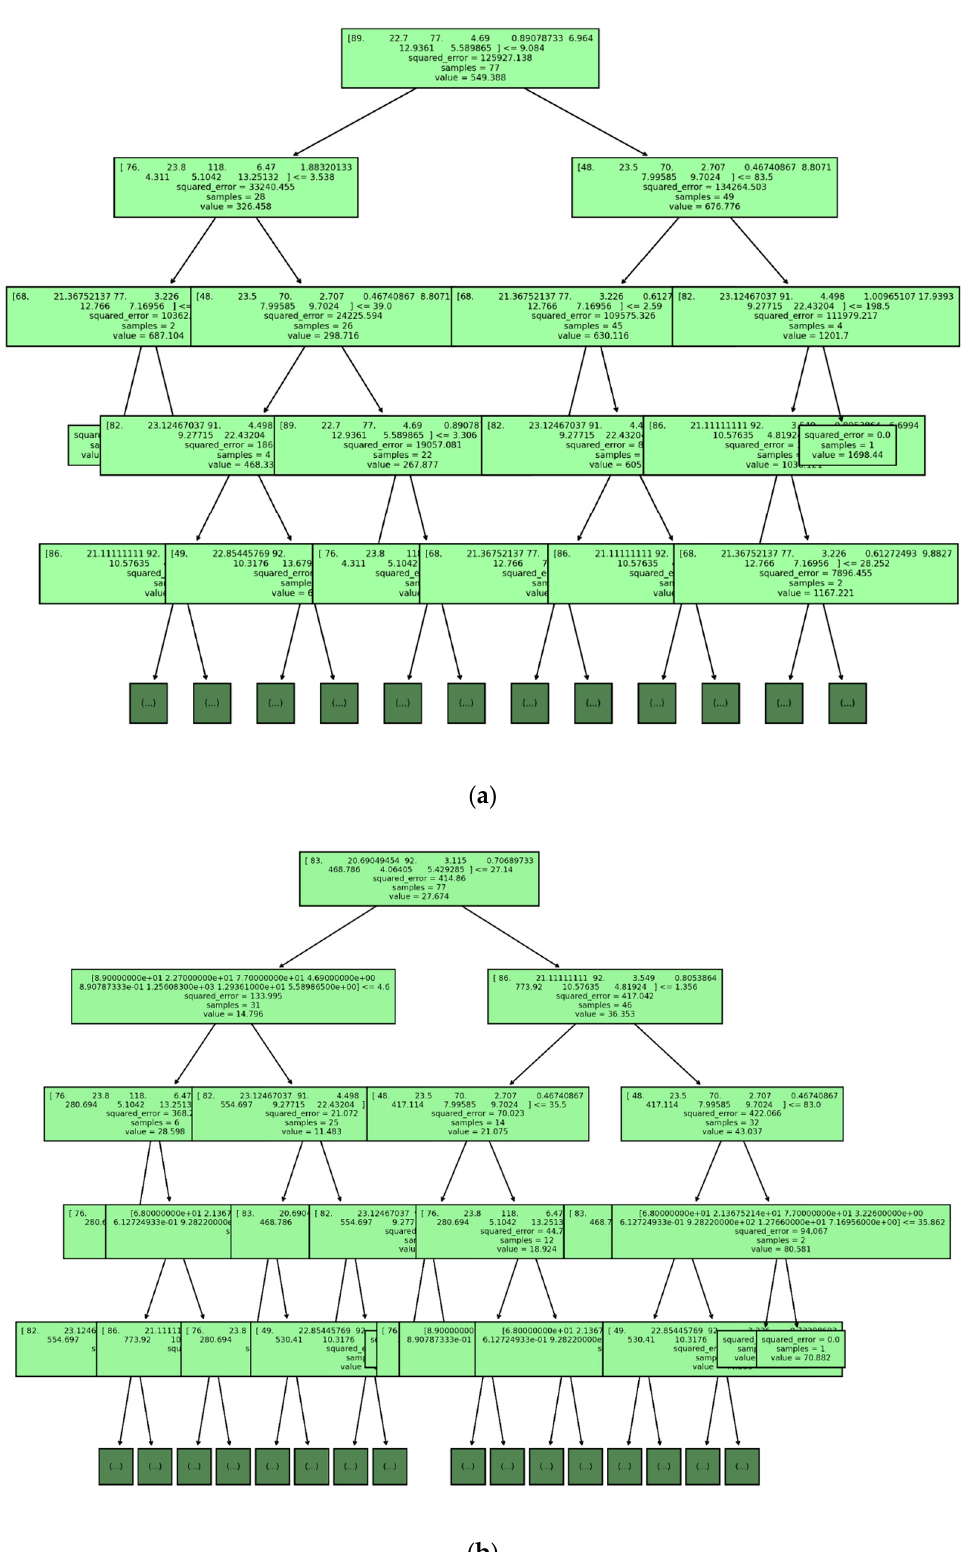
Figure 6. ( a ) The thought process of the prediction model for MCP-1 is illustrated using a decision tree visualization, which displays the feature splits and resulting predictions at each node. ( b ) A decision tree visualization is used to depict the prediction model’s reasoning process for Leptin, indicating the feature splits and resulting predictions at each node.